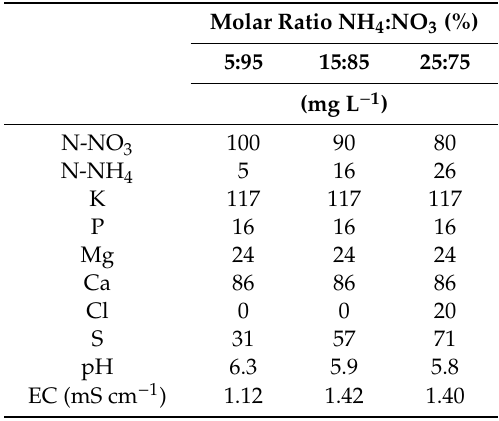
Table 2. Characteristics of the nutrient solutions used during the second